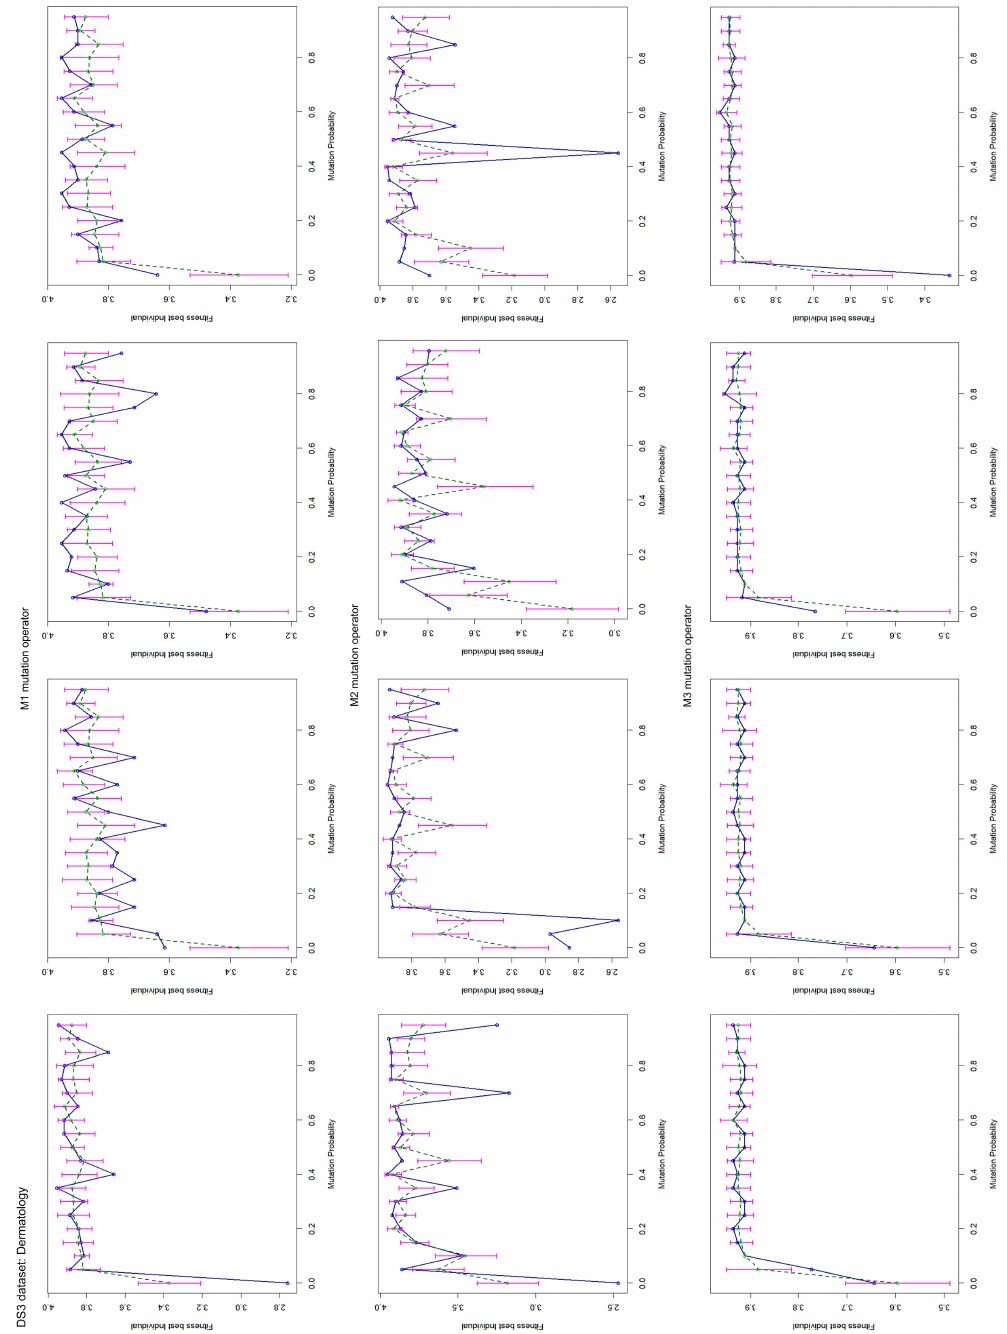
Figure A3. Mutation tests for mutation operators M1, M2, and M3 for the DS3 dataset. Each row of four graphics in the figure corresponds to the same mutation operator and each graphic corresponds to 20 executions of the evolutionary method for 20 mutation probability values with step 0.05. The blue line represents each fitness value for each mutation value. The green line represents the mean values from the four graphics in the same row and pink lines state the standard error